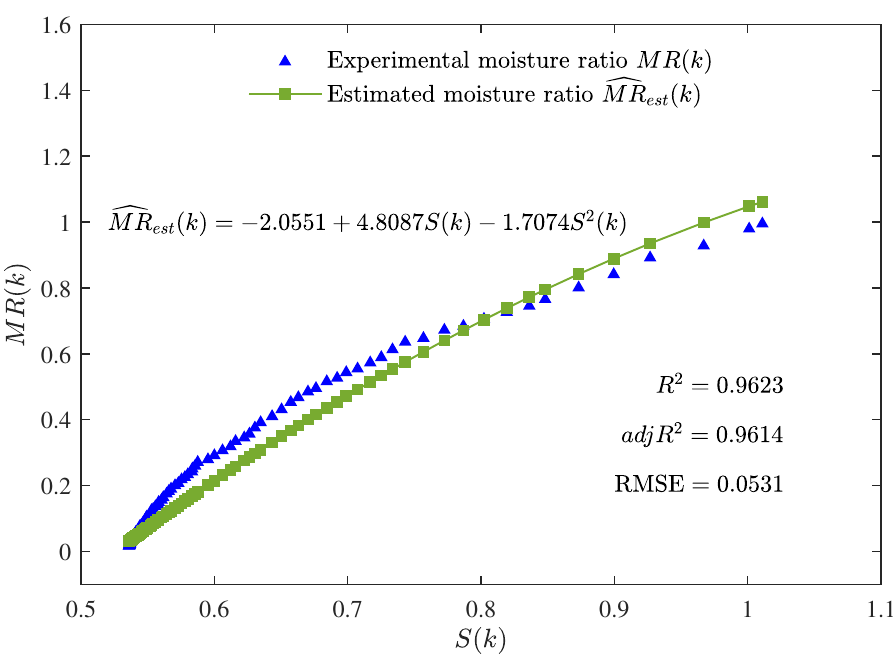
Figure 6. The estimated moisture ratio (cid:100) MR est ( k ) versus the shrinkage S ( k ) for n = 2.